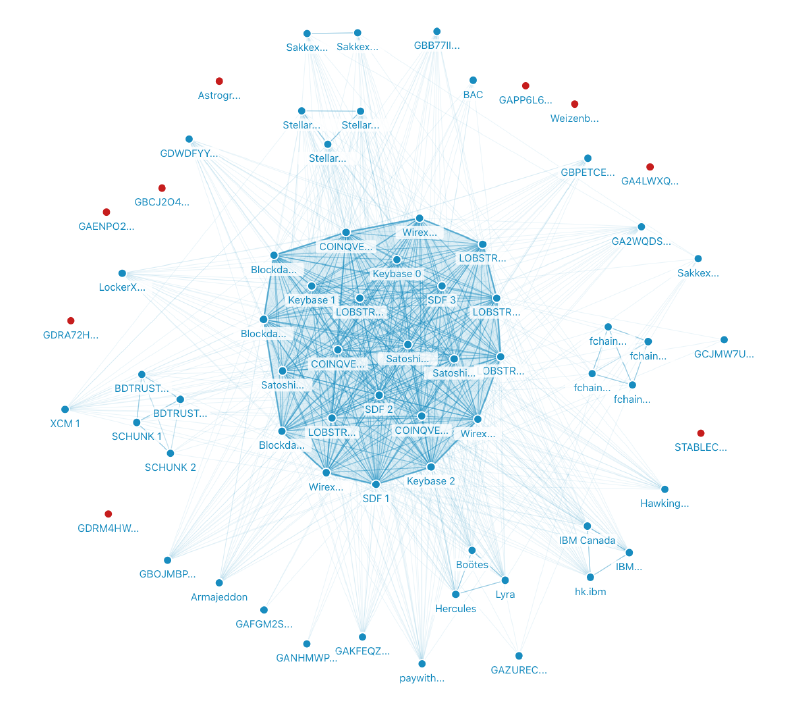
Figure 1. Stellar public network structure. Source: